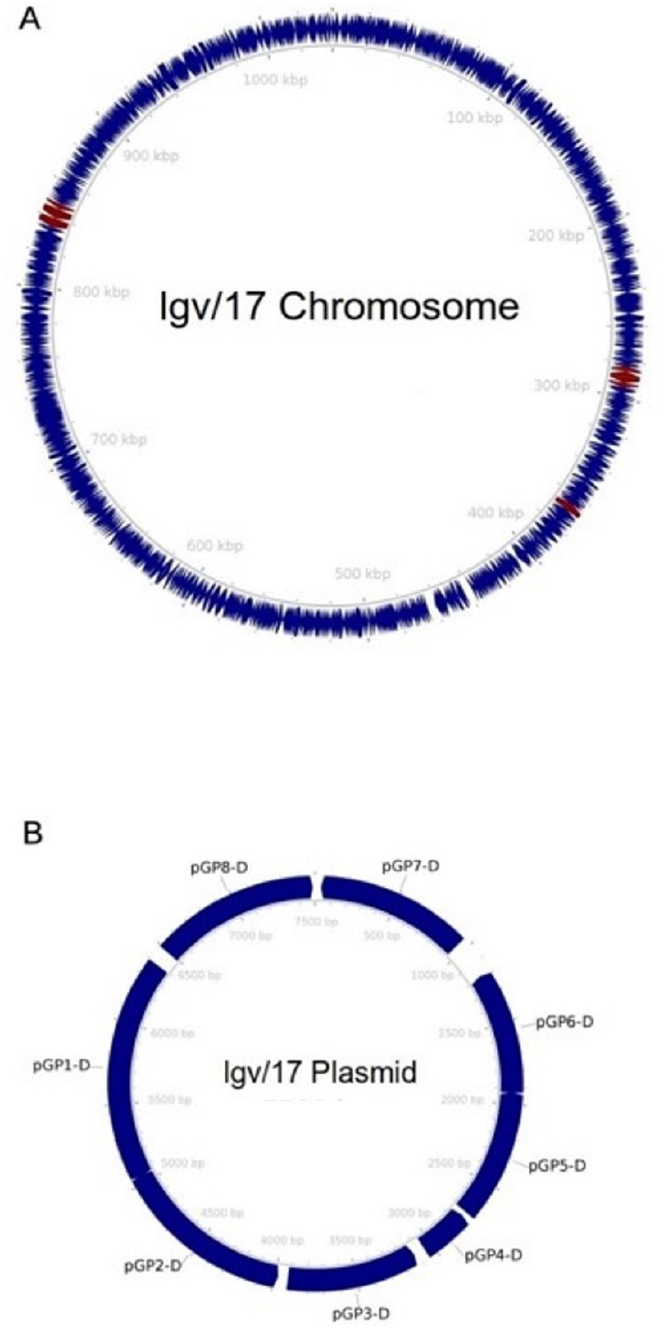
Figure 1. Graphic representation of the LGV/17 genome. The chromosome is shown in panel ( A ), while the plasmid is in panel ( B ). Coding sequences are shown as navy-blue arrows. Maroon arrows indicate genes related to virulence mechanisms.